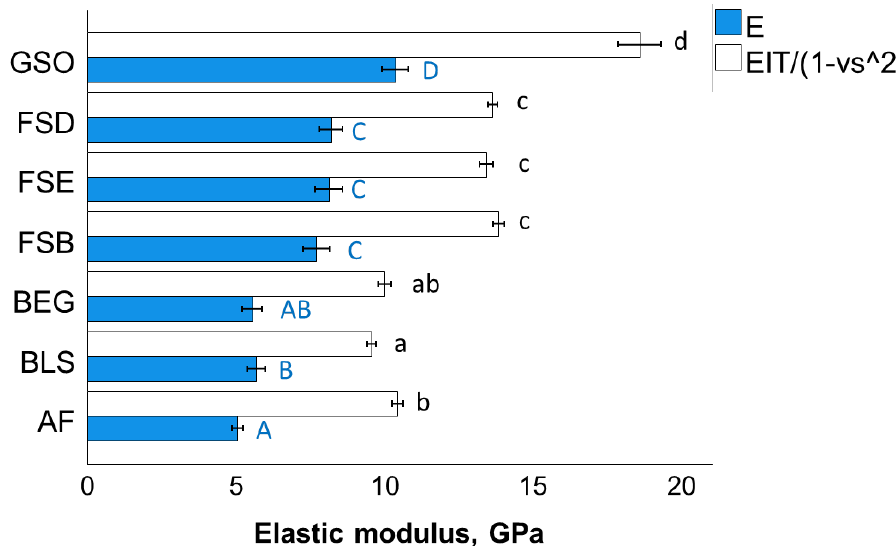
Figure 7. Indentation modulus (E IT ) in comparison to the flexural modulus (E), as a function of RBC (mean values with 95% confidence interval; capital (E) and small letters (E IT ) indicate statistically homogeneous subgroups; Tukey’s HSD test, α = 0.05). Material abbreviation: AF = Admira Fusion; BEG = Brilliant EverGlow; BLS = Beautifil II LS; FSB = Filtek Supreme XTE Body; FSD = Filtek Su- preme XTE Dentin; FSE = Filtek Supreme XTE Enamel; GSO = Grandio SO.